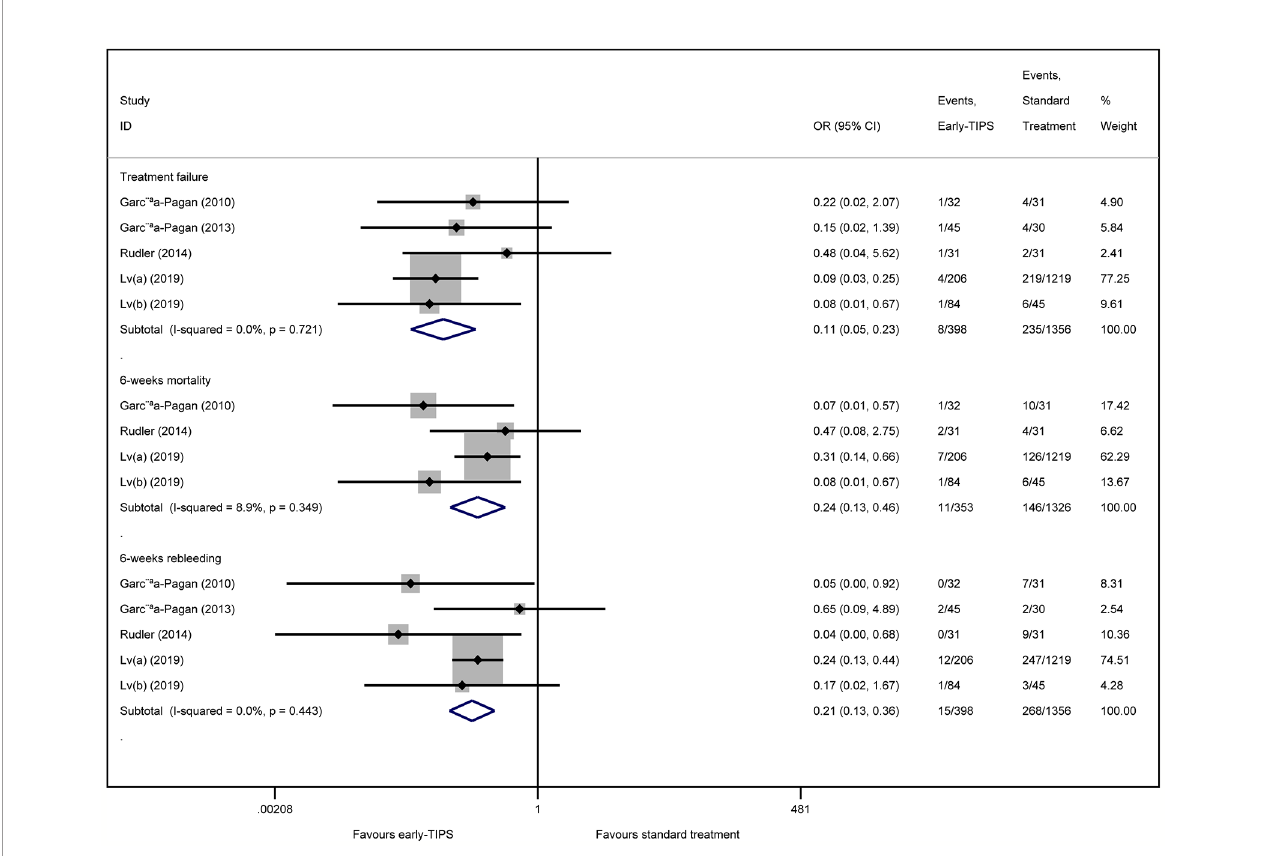
FIGURE 2 | Forest plot demonstrating treatment failure, short-term mortality (6-weeks) and short-term rebleeding risk